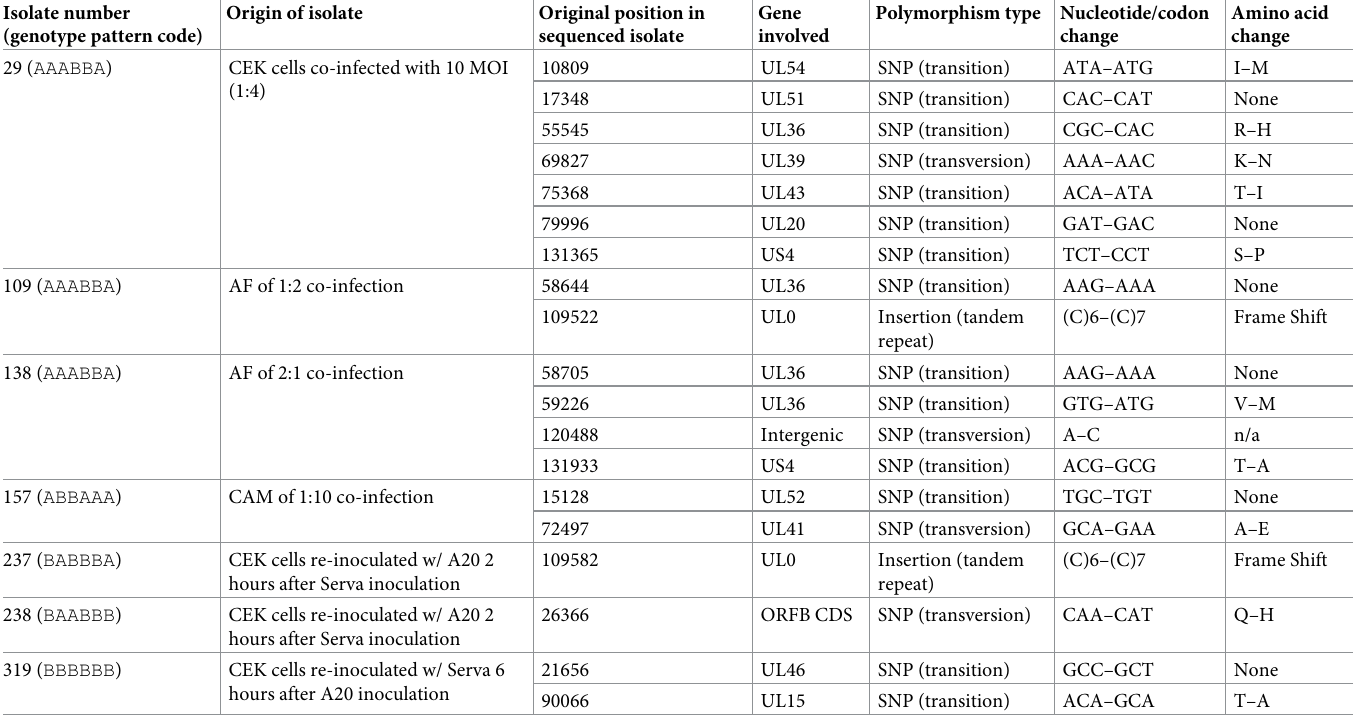
Table 4. Summary of polymorphisms in ILTV isolates sequenced in this study. Isolate number Origin of (genotype pattern code)